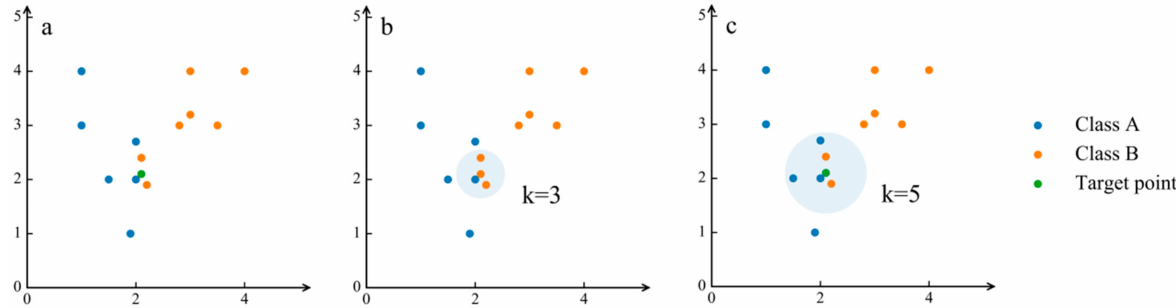
Figure 2. Principle diagram of KNN algorithm. ( a ) Target point and samples; ( b ) the result of k equal to 3; ( c ) the result of k equal to 5.